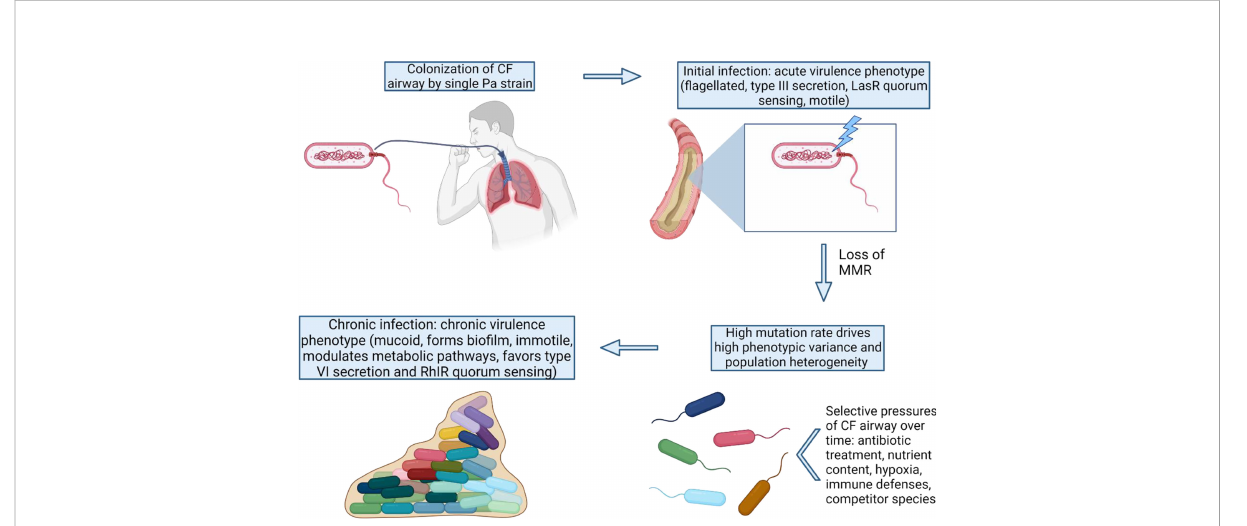
FIGURE 1 MMR-de fi ciency catalyzes the shift from an acute to chronic P. aeruginosa virulence state. Once MMR is lost in the initial colonizing strain, many adaptive pathways can be exploited by Pa via high mutation rates. The variants with mutations favoring the chronic virulence state confer advantages for long-term survival and persistence under the strong selective pressures of the CF